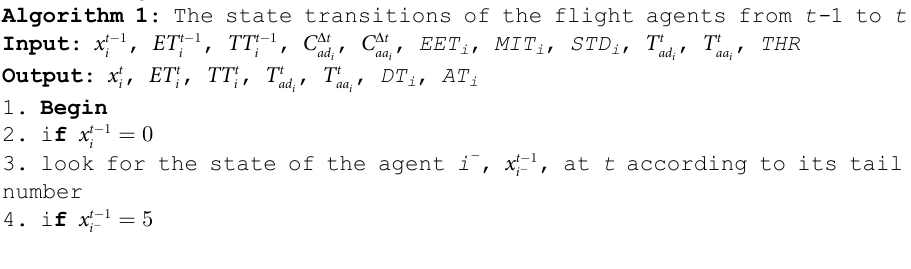
Algorithm 1 : The state transitions of the flight agents from t- 1 to